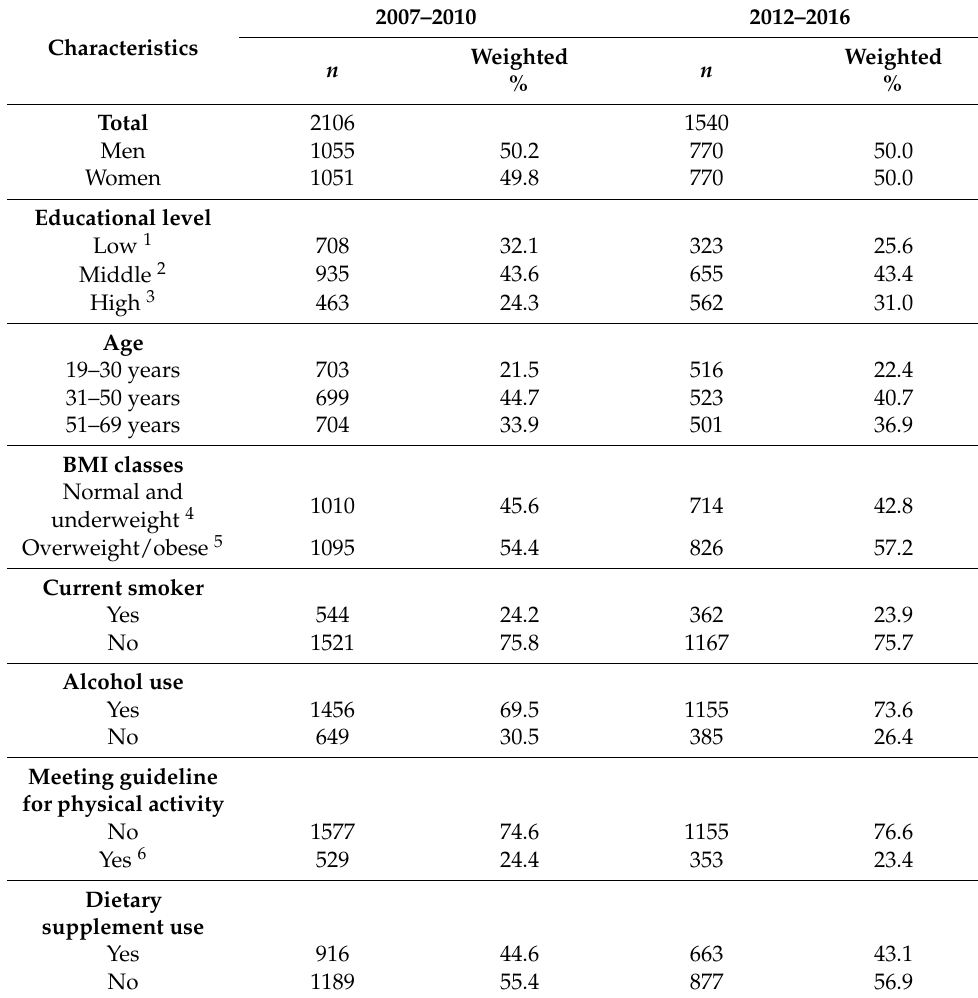
Table 1. Characteristics of adults (19–69 years) participating in the Dutch National Food Consumption Surveys in 2007–2010 ( n = 2106) and 2012–2016 ( n =